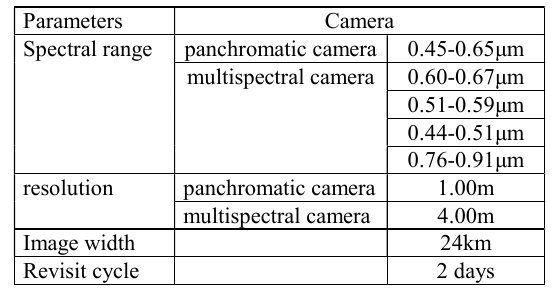
Table 2. Main parameters of Beijing-2 satellite